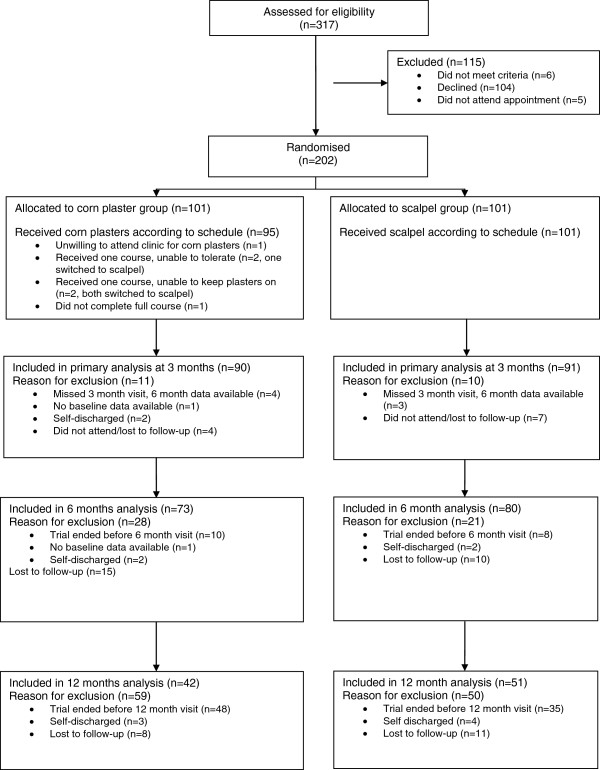
Flow of participants through the trial.